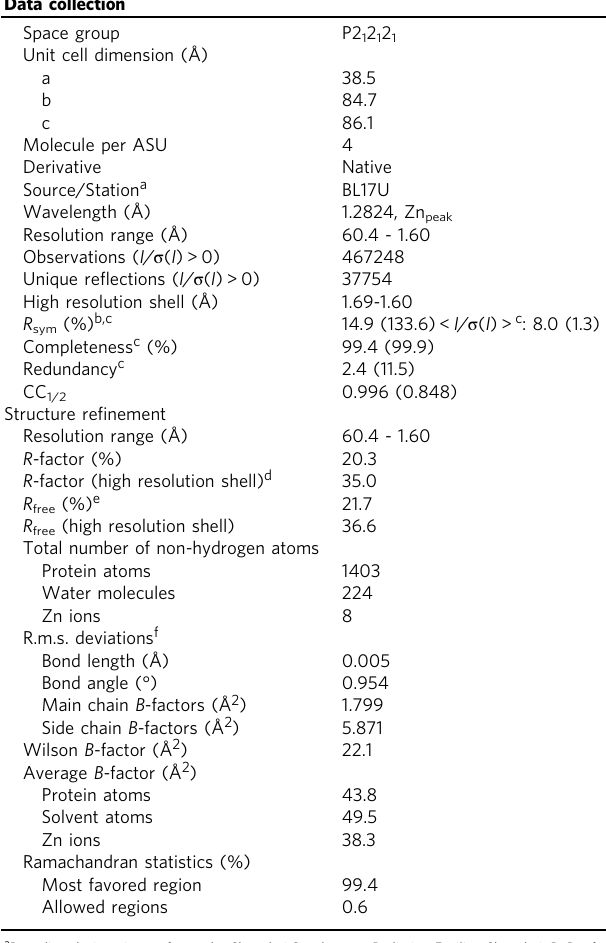
Data availability . Coordinates and structure factors have been deposited in the Protein Data Bank under accession code 5YUF. Other data are available from the corresponding authors upon request.